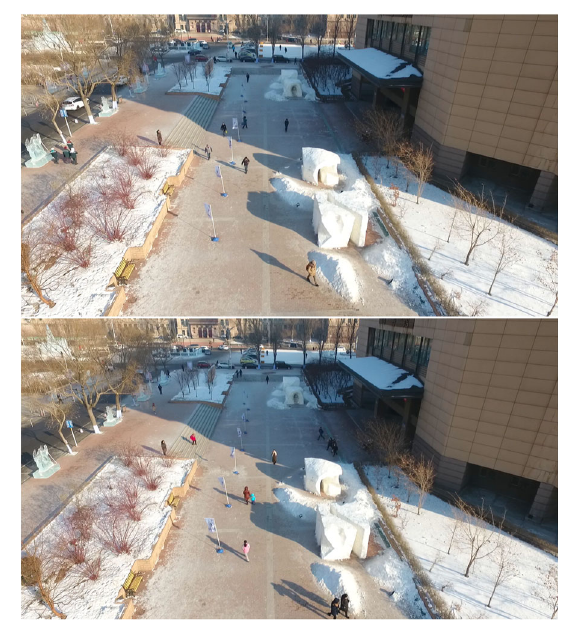
Fig. 1 Examples of images taken by